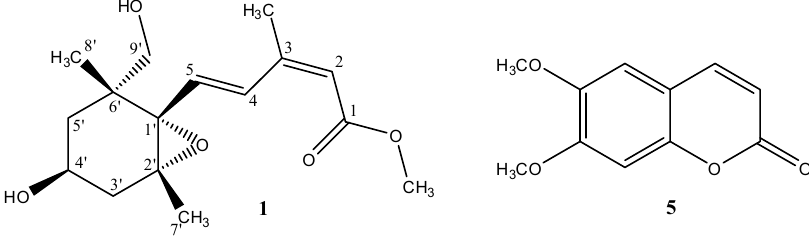
Figure 1. Structures of compounds 1 (relative configuration) and 5 .